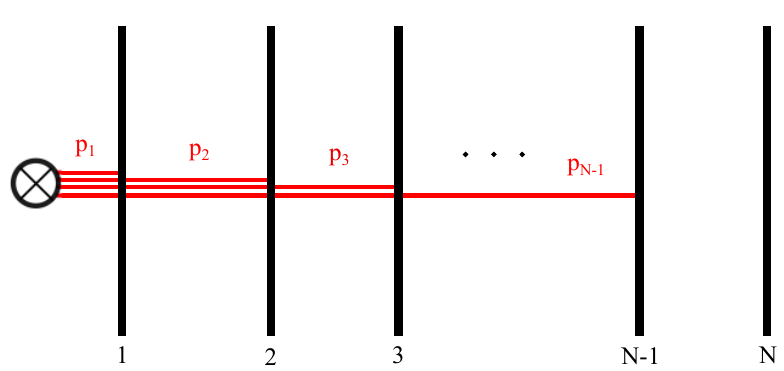
Figure 1 . This (cid:12)gure illustrates the brane construction of a generic ’t Hooft defectin the SU( N ) N = 2 SYM theory with ’t Hooft charge P = P